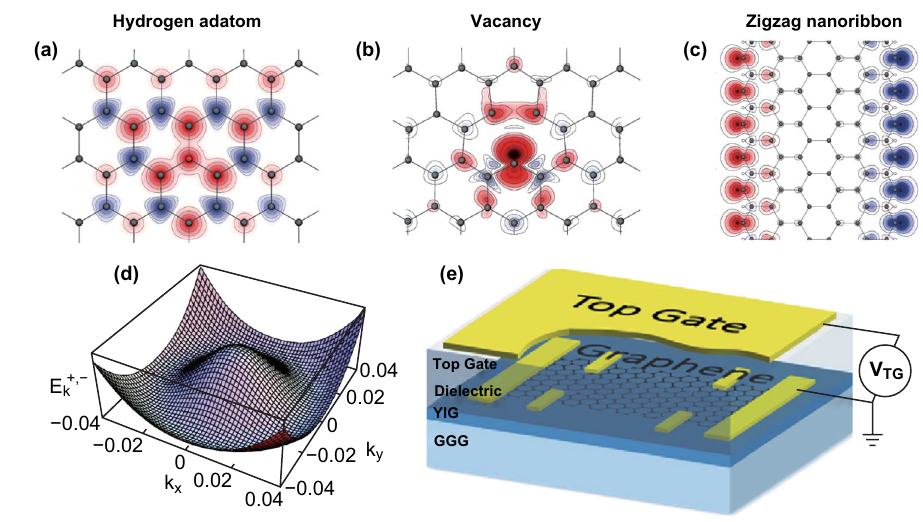
Fig. 1 Schematic diagram of magnetic engineering strategy. a Hydrogenated graphene. b Vacancy graphene. c Graphene nanoribbon. Different colors represent magnetic moments in different directions [15]. d Calculated Mexican hat band dispersion in electrically biased Bernal stacked bilayer graphene. The diverging electronic DOS at the edge of the Mexican hat potentially results in ferromagnetic Stoner instability [38]. e Schematic drawing (with top gate) of the devices, which can prove the proximity‑induced ferromagnetism in graphene transferred to a YIG/GGG substrate [41]. Figures reproduced with permission from Refs. [15, 38, 41]. (Color figure